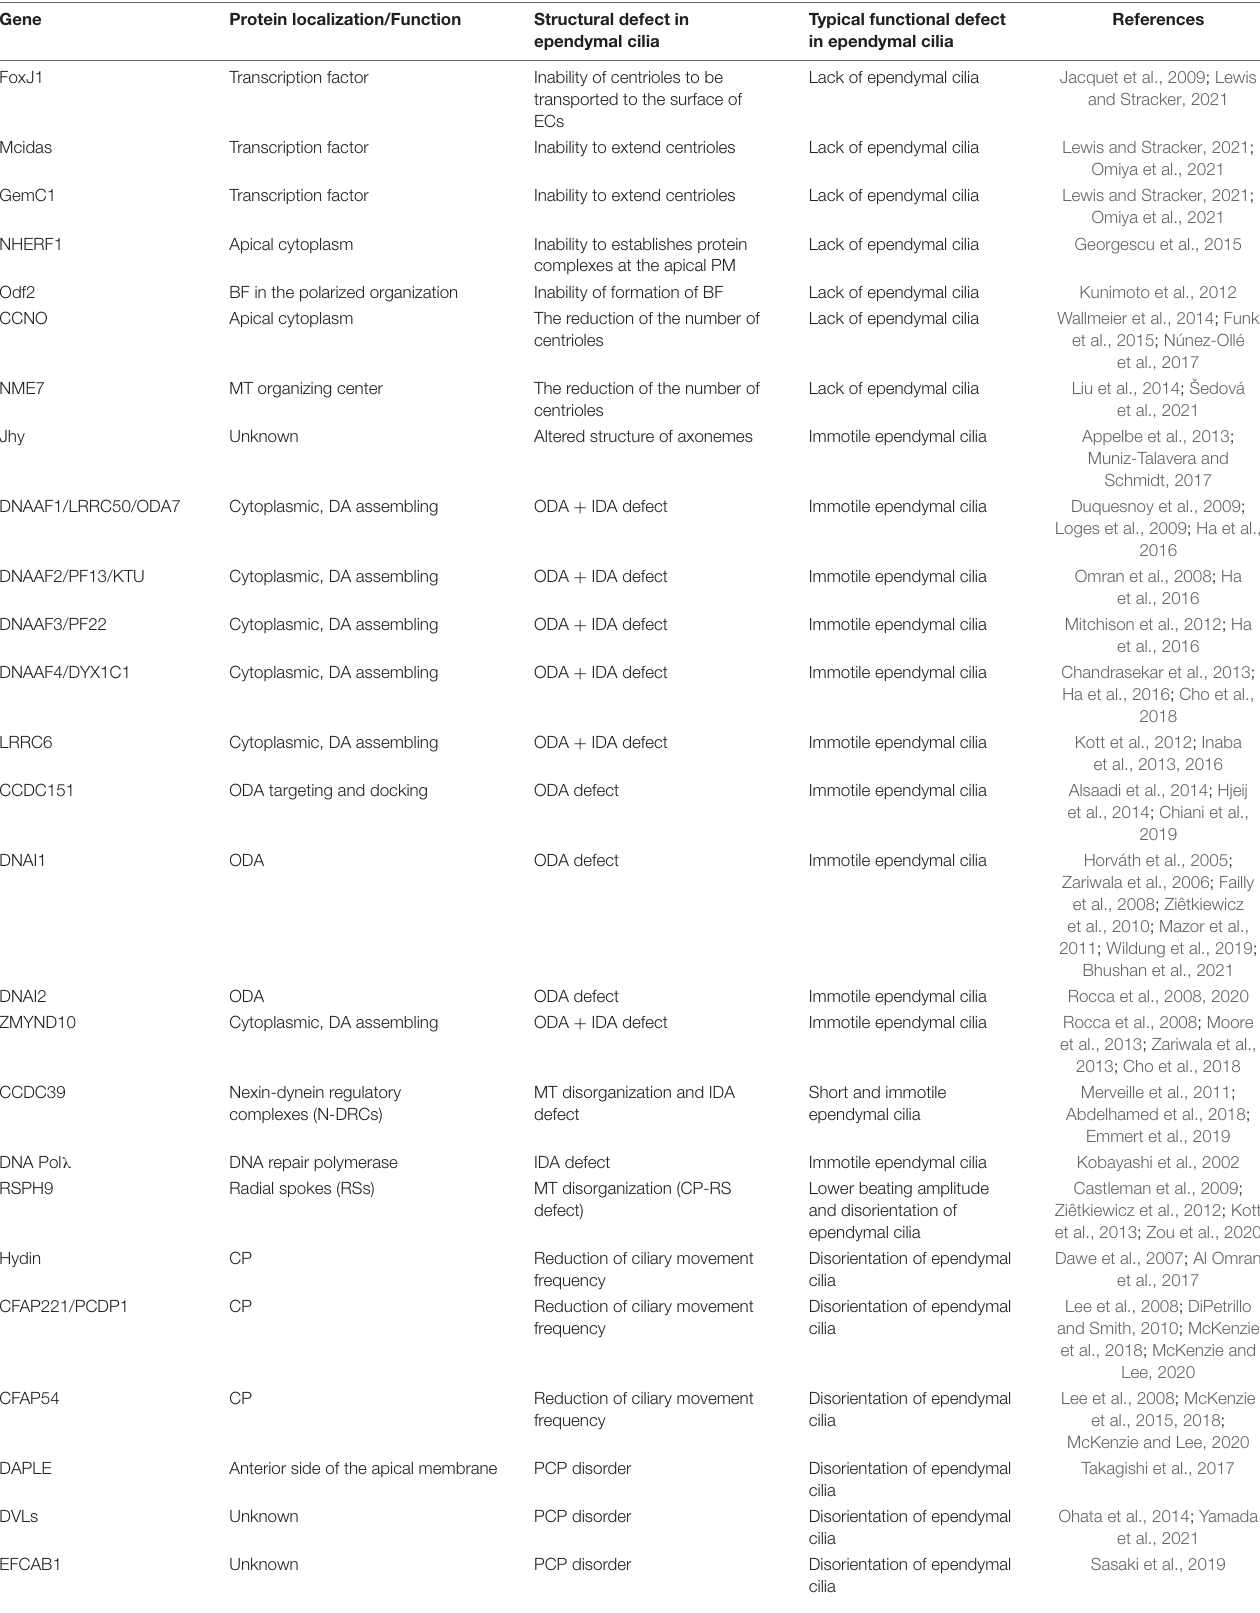
TABLE 1 | A comprehensive list of ependymal cilia dysfunction-related genes.